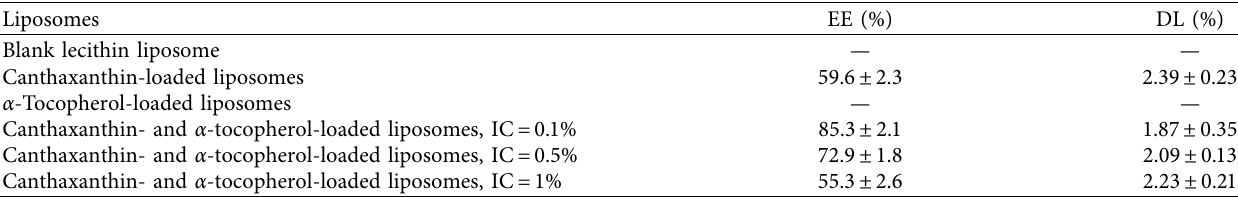
Table 3: EE and DL of blank lecithin liposome, canthaxanthin-loaded liposomes, α -tocopherol-loaded liposomes, canthaxanthin- and α -tocopherol-loaded liposomes with IC � 0.1%, canthaxanthin- and α -tocopherol-loaded liposomes with IC � 0.5%, and canthaxanthin- and α -tocopherol-loaded liposomes with IC � 1%.